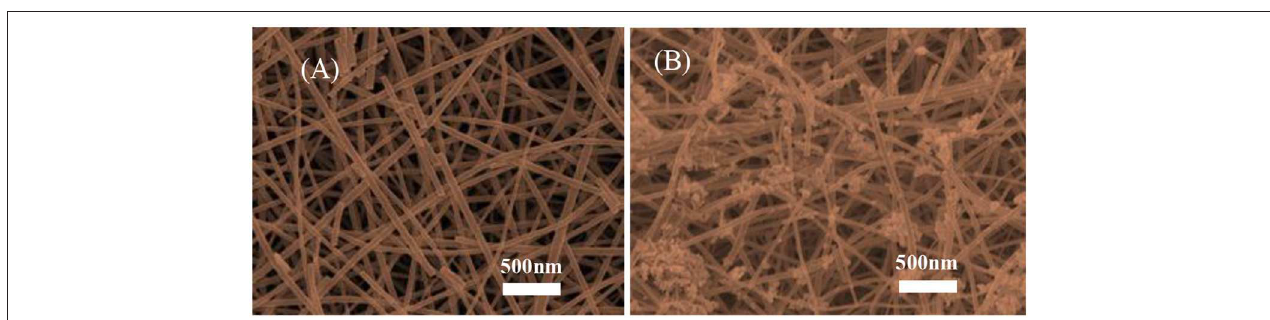
FIGURE 3 | The SEM images of (A) pure SnO 2 NFs. and (B) Cr 2 O 3 NPs. coated SnO 2 NFs.